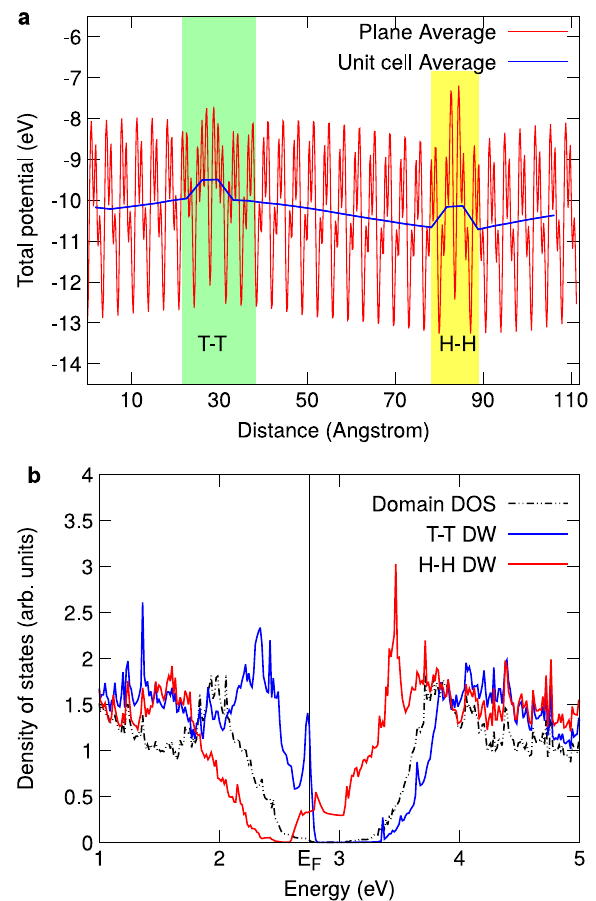
Fig. 2 Con fi nement of free charge carriers at domain walls. a Averaged total potential of GeTe containing 39 ∘ (11 1 ) tail-to-tail (T-T) and head-to-head (H-H) domain walls (DWs), represented by the green and yellow shaded regions respectively, as a function of the coordinate normal to the DWs. The potential drop along domains arises from polarization discontinuity at the DWs. b Electronic local density of states in the middle of domains and at the domain walls. The local density of states (LDOS) of domain walls is obtained by summing the LDOS of the atoms in six primitive unit cells near the domain wall plane. E F is the Fermi energy of the system at 0 K. For the H-H and T-T DW, the Fermi level lies above and below the forbidden gap, supercell containing 39° H-H and T-T DWs and projected it on the DW plane, see Fig. 3a. Blue lines correspond to the eigenvalues of the states with the reciprocal lattice vector normal to the DW plane ( k 3 ) set to zero. Dispersion of these states in the direction normal to the DW plane is represented by broadening given in red, which illustrates how these eigenvalues vary with k 3 . The bands close to the Fermi level E F do not have any dispersion along the direction normal to the DW plane (i.e., they have no broadening in that direction). Consequently, these states are localized and behave like a 2D electron gas, as we would expect from the potential pro fi le in Fig. 2a. Contrary to that, the bands further from E F have large broadening and are not localized. To con fi rm that the electronic states near the Fermi level are localized on the DWs, we computed the average charge densities associated with two representative states close to E F on planes parallel to the DWs as a function of the coordinate perpendicular to the DWs, see Fig. 3b. These states are indeed con fi ned to the DWs and do not extend into the domains. The valence band states are localized on the T-T DW, while the conduction band states are